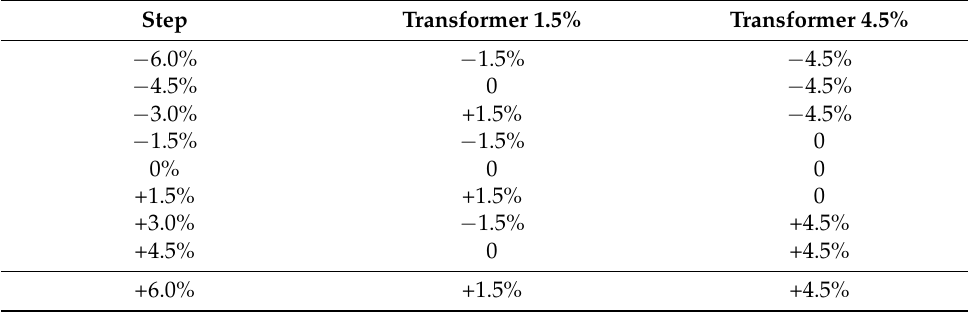
Table 1. Generated voltage steps using thyristors; data according to